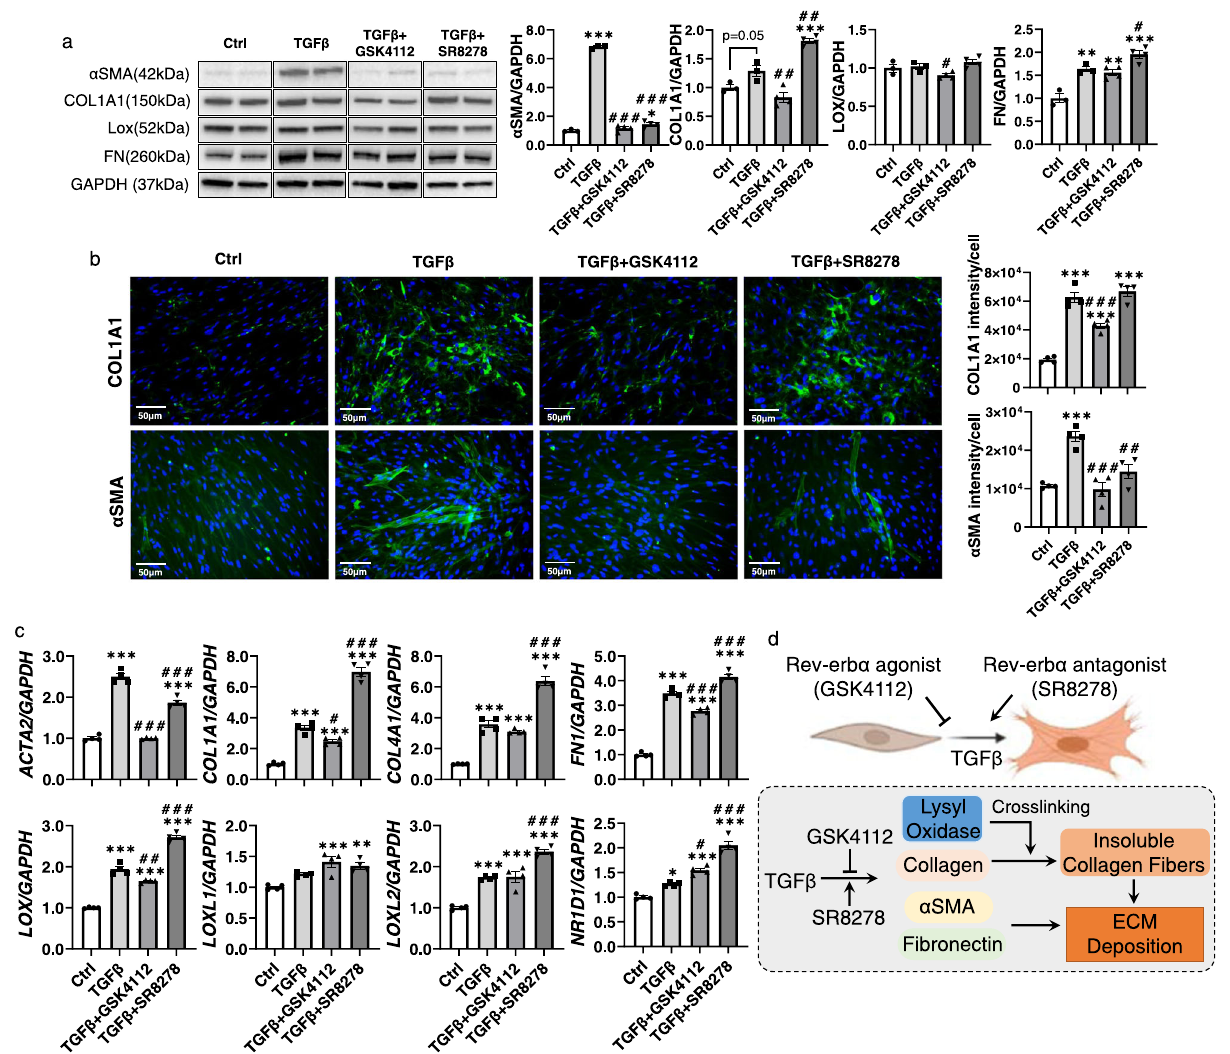
Fig. 8 | Rev-erb α agonist inhibits TGF β induced fi broblast differentiation and antagonistsexacerbateit. Humanprimarylung fi broblastweretreatedwithTGF β (2ng/ml) with or without Rev-erb α agonist (GSK4112, 20 µ M) or antagonist (SR8278,20 µ M)for2days. a Proteinwasisolatedforwesternblotanalysis( α SMA, COL1A1, LOX, and Fibronectin (FN)). Represented blots are shown with densito- metry analysis ( n =3 – 4 cells per group). b Immuno fl uorescence staining showed the distribution and protein abundance of COL1A1 and α SMA, DAPI was used for nuclear staining (×20). Relative fl uorescence intensity was calculated in ImageJ, as fl uorescence intensity per cell ( n =4 cells per group). c RNA was isolated for gene expression measurement via qPCR ( ACTA2 , COL1A1 , COL4A1, FN1, LOX , LOXL1,